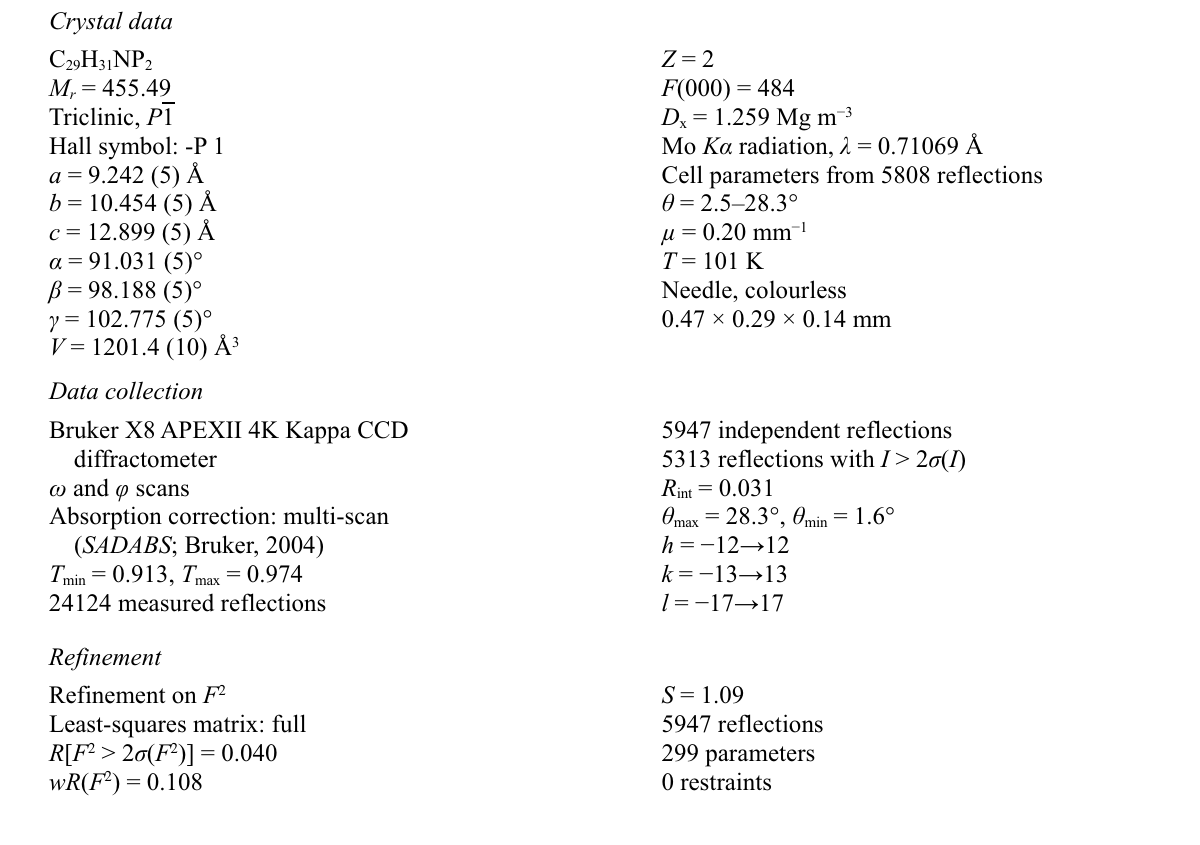
Figure 3 A perspective view of the unit cell of (I) along the b axis. N , N